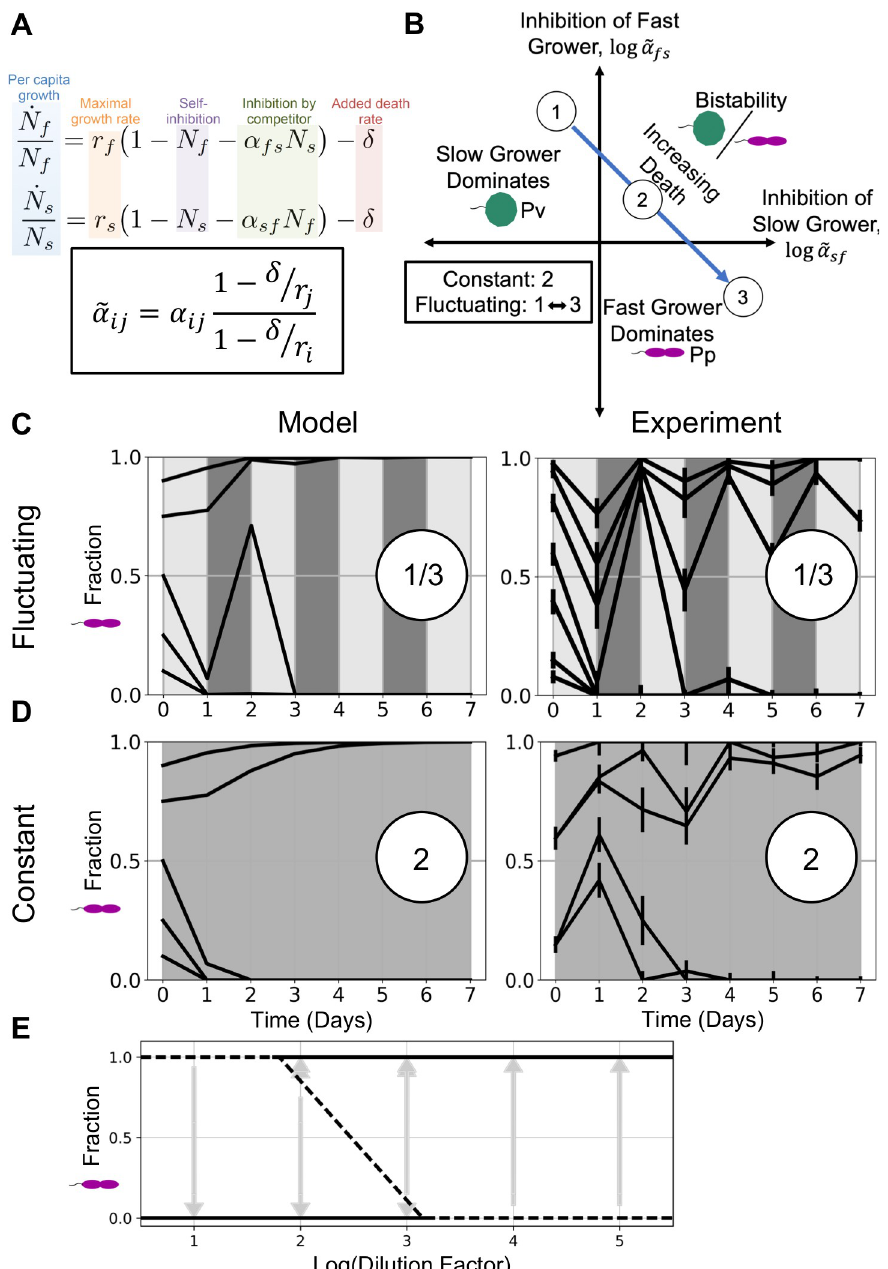
Fig 2. Bistability occurs in both fluctuating and average environments, confirming model prediction. To understand the results from Fig 1, we employed a modified Lotka-Volterra (LV) model. A : We model daily dilutions by adding a community-wide death rate term δ to the two-species LV competition model. The per-capita growth rate is a function of a species’ maximum growth rate, self-inhibition, and competition with the other species. Because the per-capita growth rate is linear and additive, the model predicts that the outcome of a fluctuating environment should be the same as that of the time-averaged environment (S2 Text). The LV model can be reparametrized to eliminate the death rate δ by defining new competition coefficients ~ a ~ , which are functions of death δ and growth r , as shown (S1 ij Text). B : The solutions to the LV model can be represented by a phase space of the re-parameterized competition coefficients ~ a ~ . If a slow grower dominates at low or no added death, increasing mortality will favor the fast grower, ij causing the pair to pass through a region of bistability or coexistence on the way to fast grower dominance. Here we have illustrated the trajectory of a bistable pair. C-D : To test the prediction that the fluctuating and time-averaged environments are qualitatively equivalent, we cocultured Pp and Pv at a dilution factor equal to the time-average of the